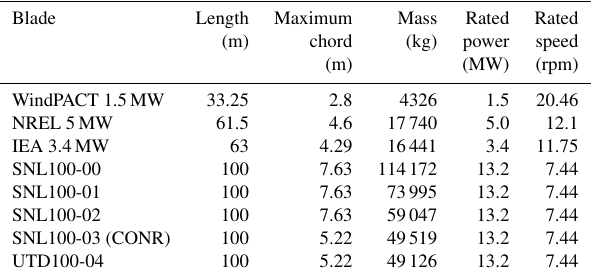
Table 1. Geometry and operating specification of the three-bladed wind turbine blade models examined in the study. The blades are sorted by blade length.